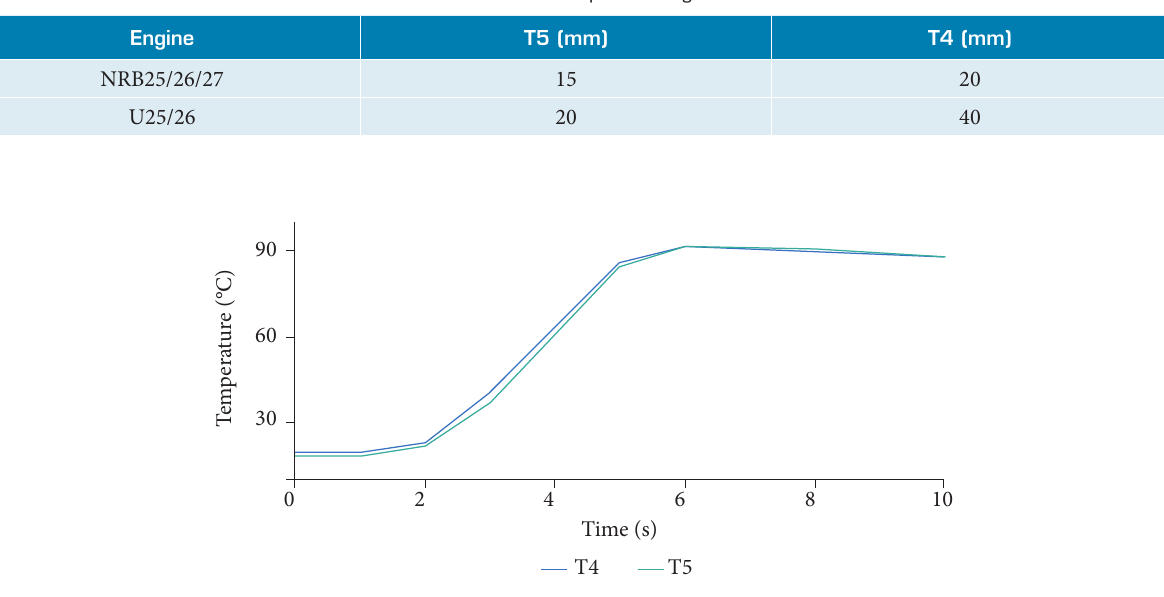
Table 4. Position of thermocouples during the static test.